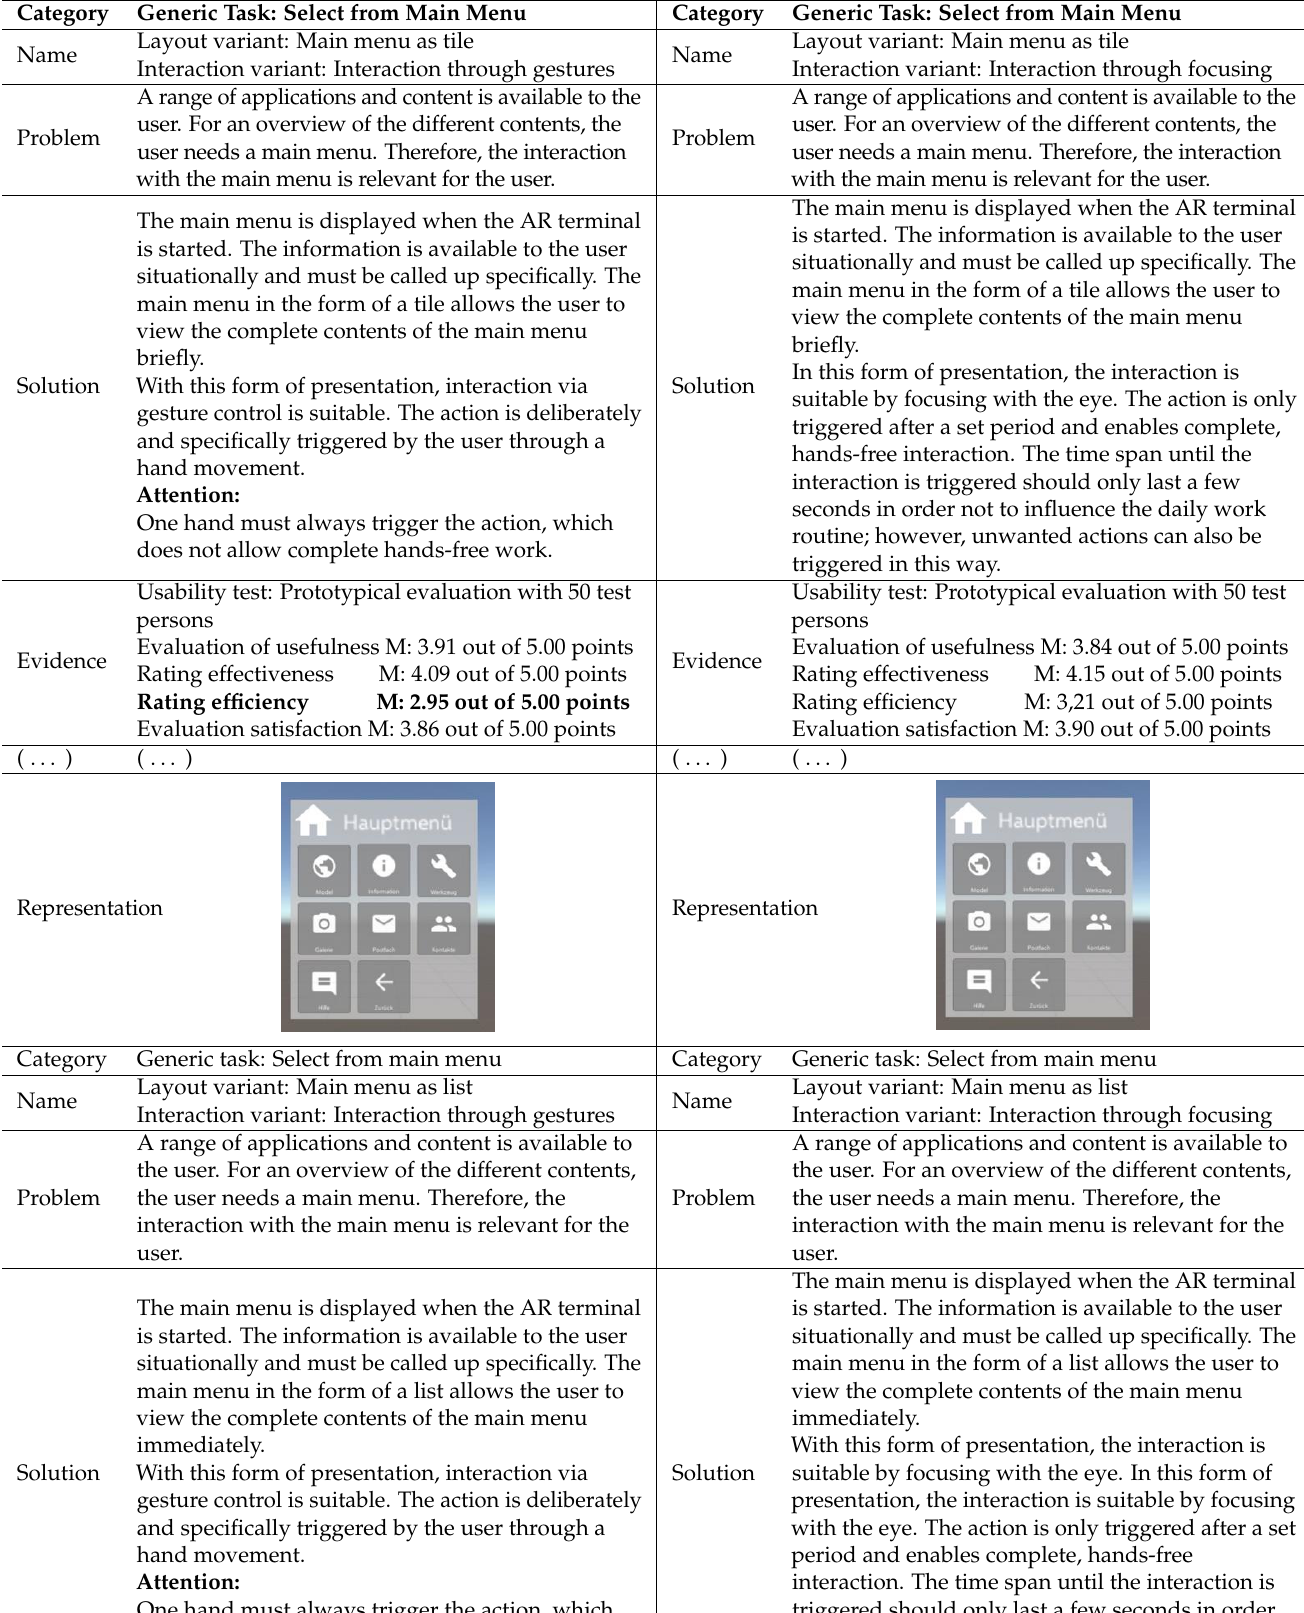
Table 13. Examples from the catalog with pattern. Part 2: Variants of